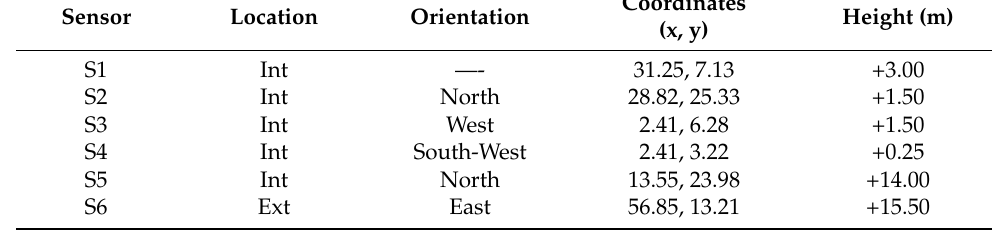
Table 2. Location of the data-loggers in the building.